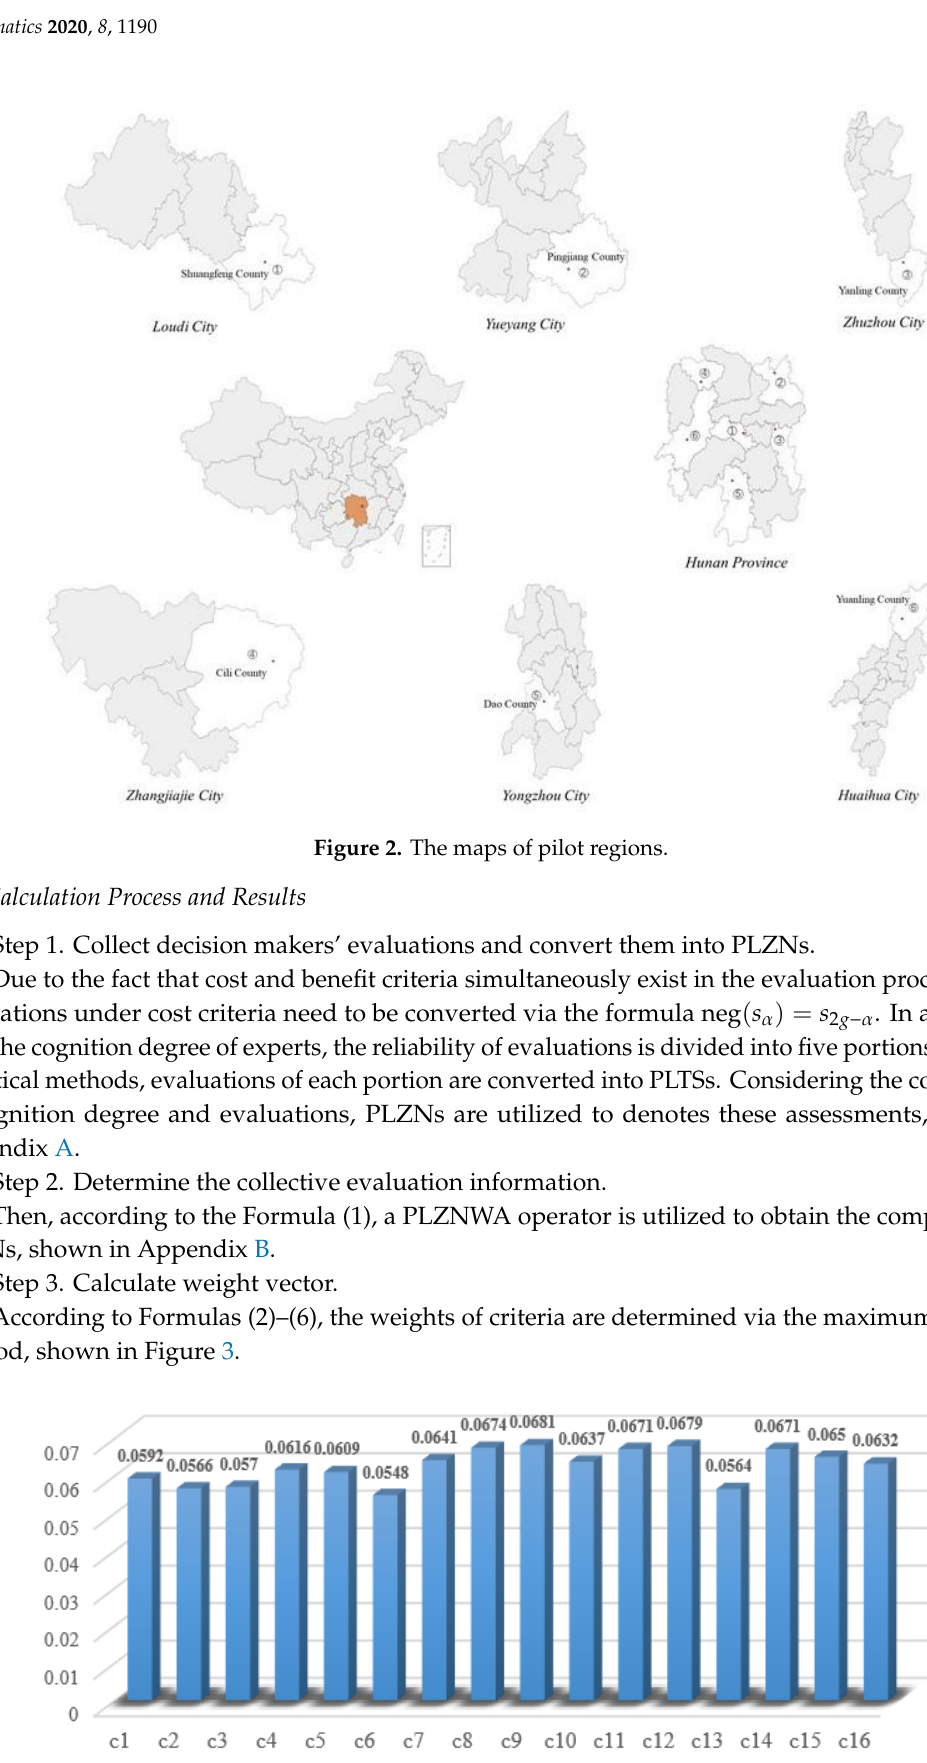
Figure 3. The weight comparison among sixteen sub-criteria.